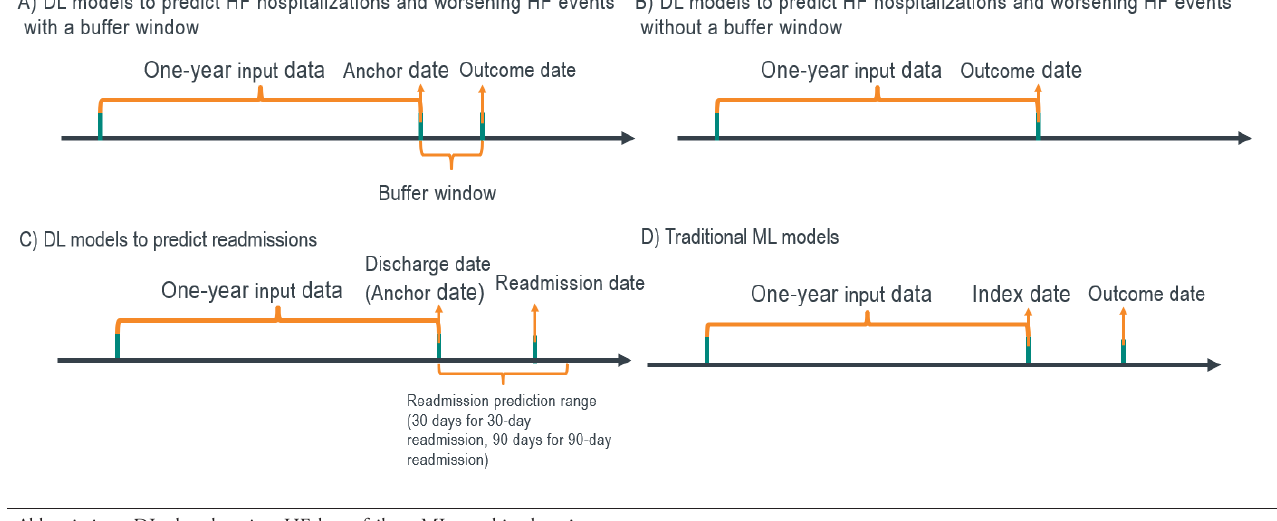
Figure 1. Study Design